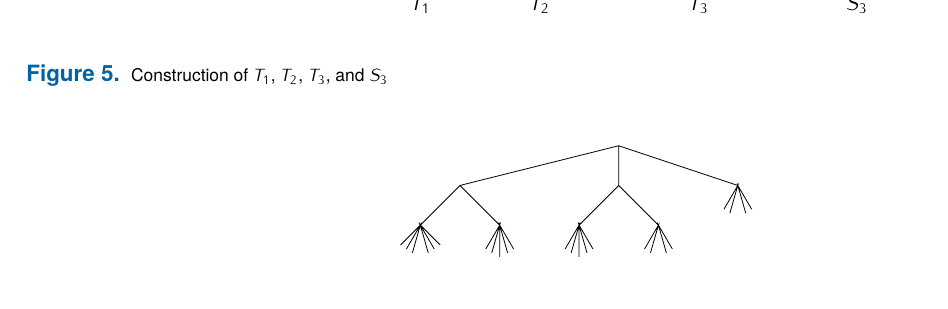
Figure 6. The alternating greedy tree